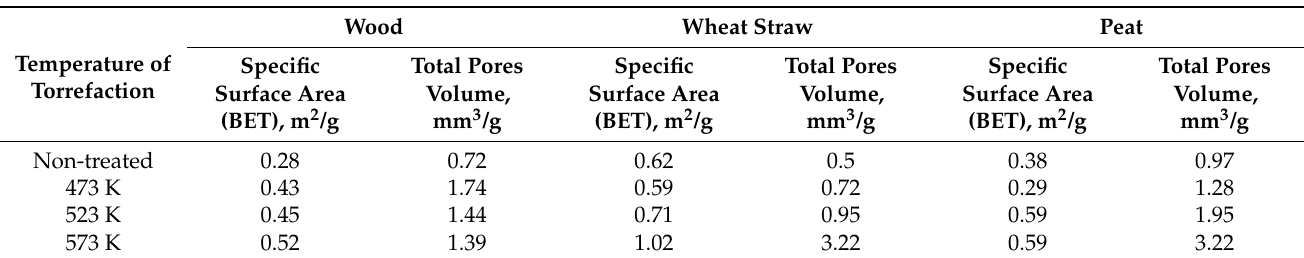
Table 1. The effect of increasing the temperature of mw pretreatment on changes of the surface area and porosity of pretreated